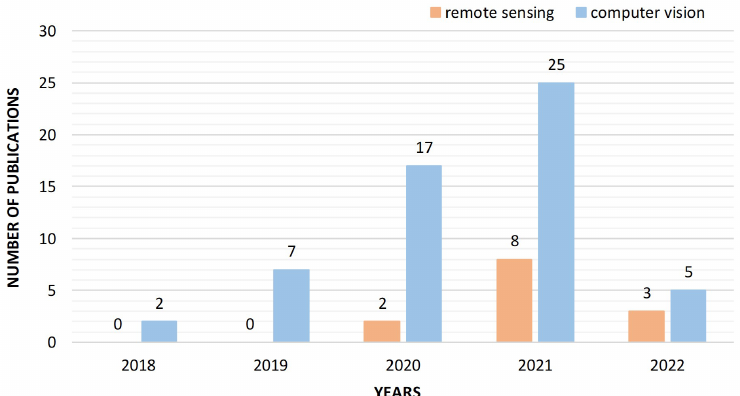
Figure 2. Published literature statistics of FSOD in both remote sensing image interpretation and computer vision fields. The statistics are counted according to the keywords “remote sensing” and “few-shot object detection” up to March 2022 in Web of Science and Engineering Village, acquiring a total of 69